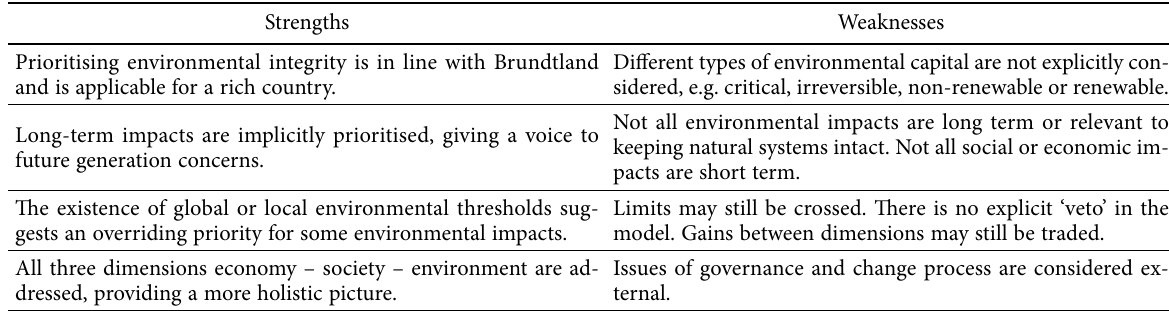
Table 1. Nested model strengths and